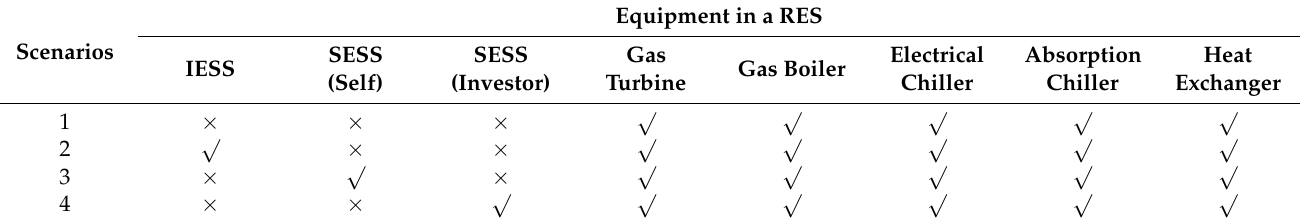
Table 1. Different scenarios.